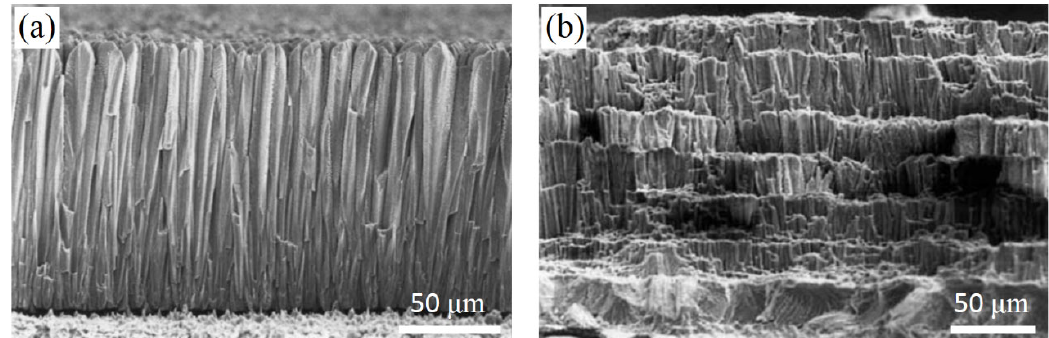
Fig. 69 SEM micrographs showing fracture surfaces of 8YSZ produced by EB-PVD using two different approaches: (a) “shutter” method and (b) “in & out” method. Reproduced with permission from Ref. [395], © Kluwer Academic Publishers